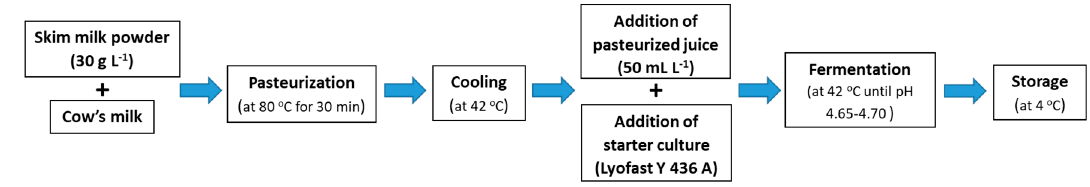
Figure 1. Protocol for the manufacture of yogurts supplemented with juices from grapes and berries.